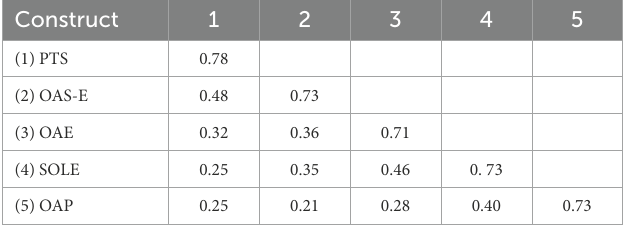
TABLE 4 Discrimination validity